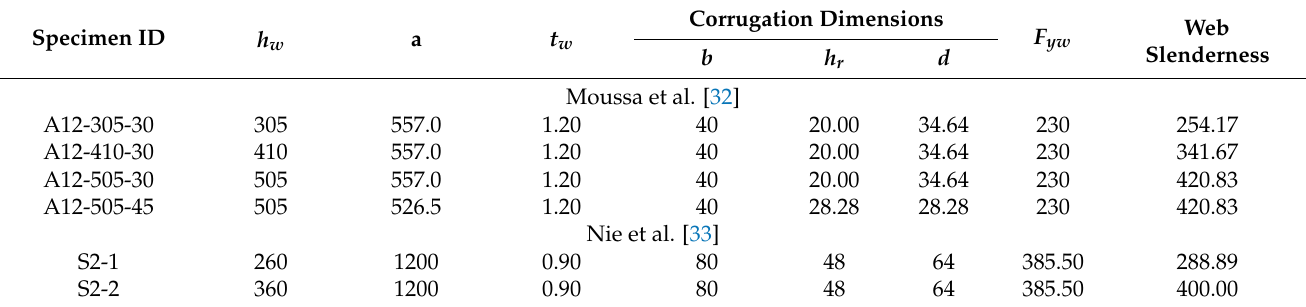
Table 5. Data of specimens tested in previous studies.